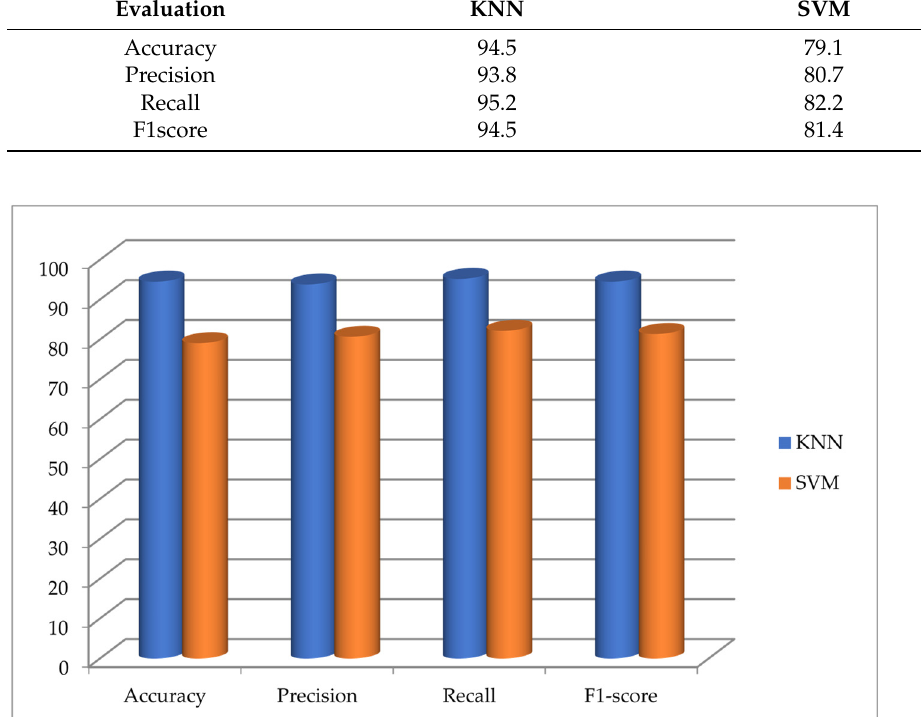
Figure 4. Graph of results of accuracy, precision, recall, and F1score.